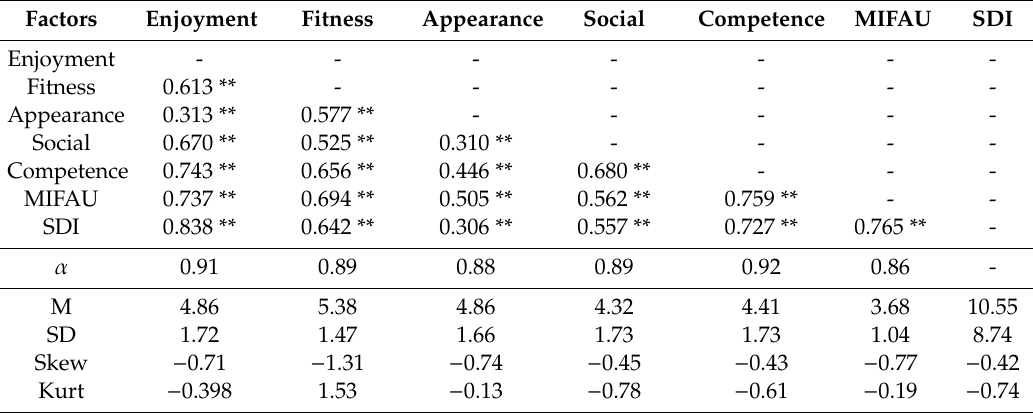
Table 2. Descriptive analysis and correlations of the